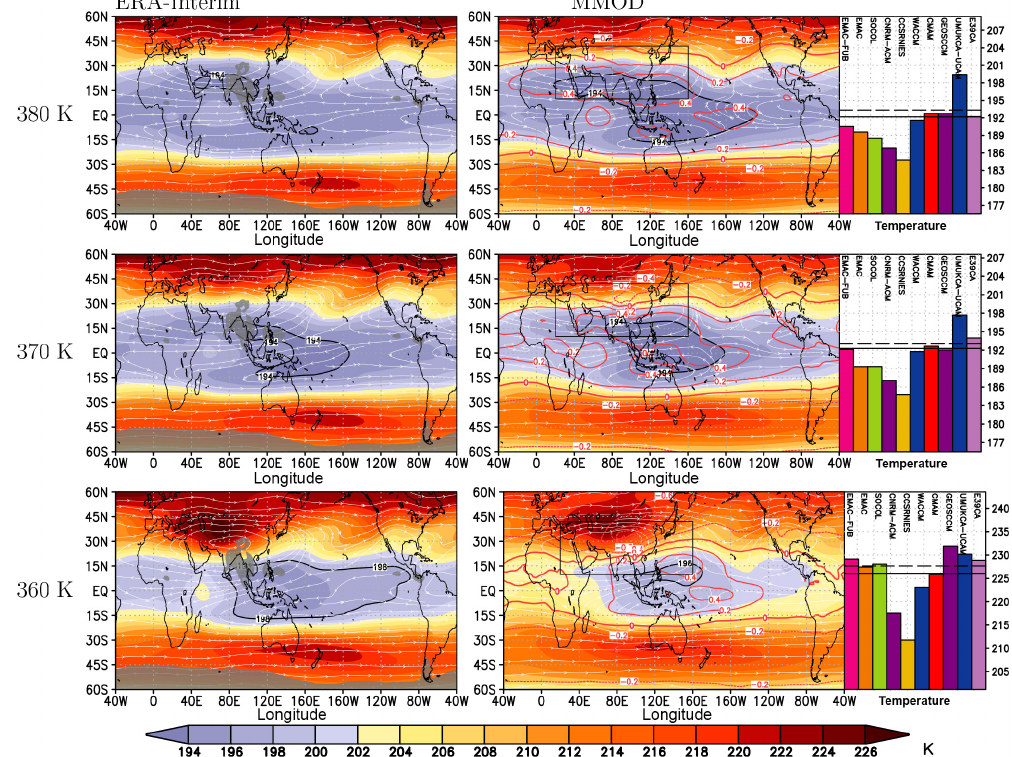
Figure 4. As Fig. 3 but for temperature. Left column: JA ERA-Interim temperature averaged from 1979 to 2014. Contour lines for the lowest temperatures of the multi-model average are given in black: 296K (at 360K) and 294K (at 370 and 380K). At 370 and 380K the minimum (at 360K the maximum) of individual models within the area marked by the black rectangle is displayed as bar chart, where the solid horizontal line represents the MMOD and the dashed horizontal line represents the value for